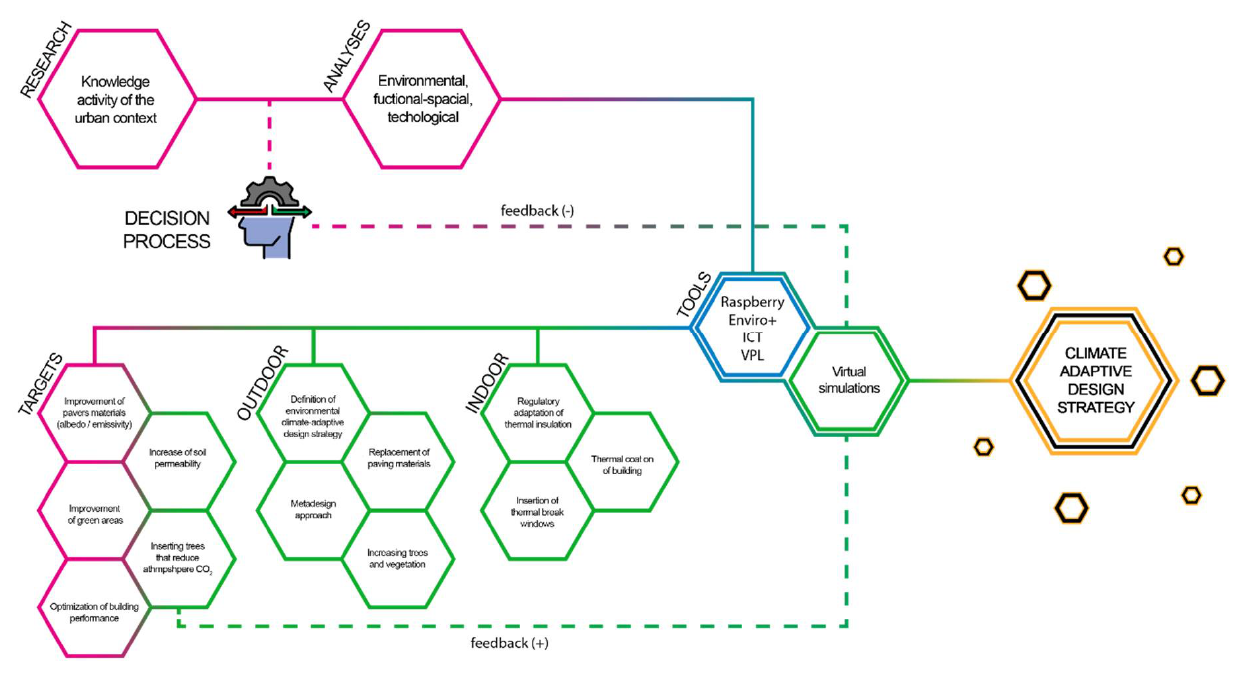
Figure 1. The developed methodological framework.